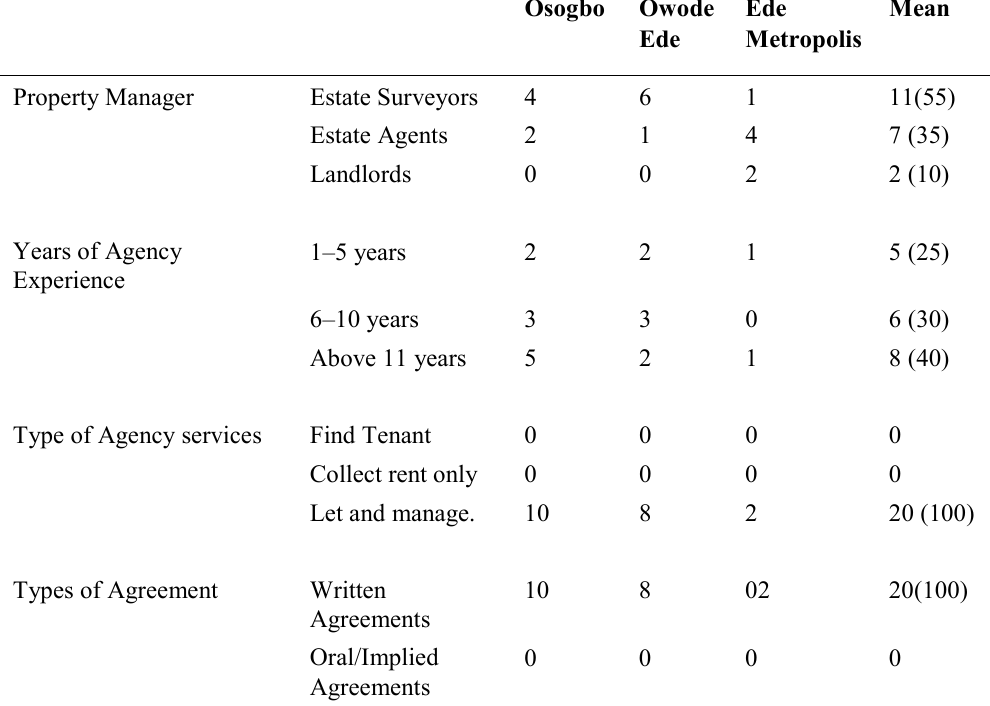
Table 2. Types of Management Agents and Nature of Services